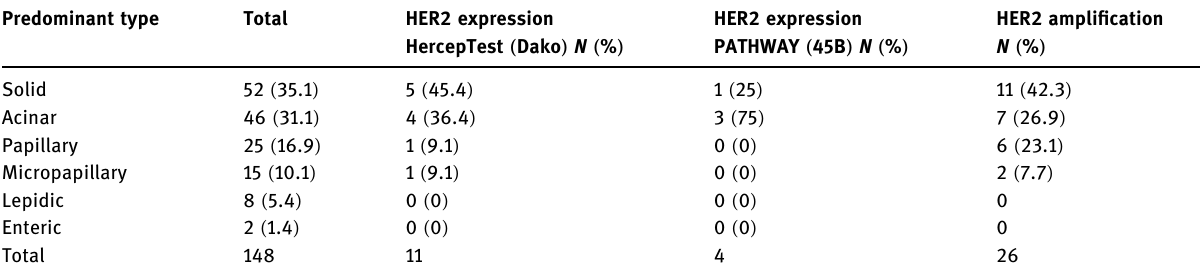
HER2, human epidermal growth factor receptor 2; N , number.